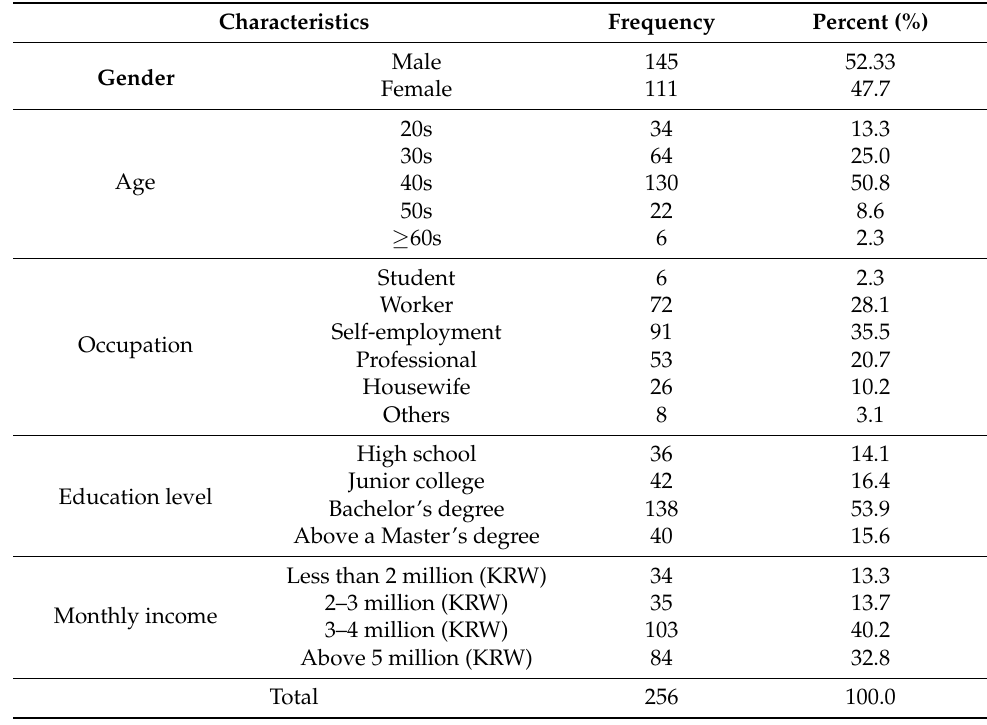
Table 1. Demographic characteristics of respondents.